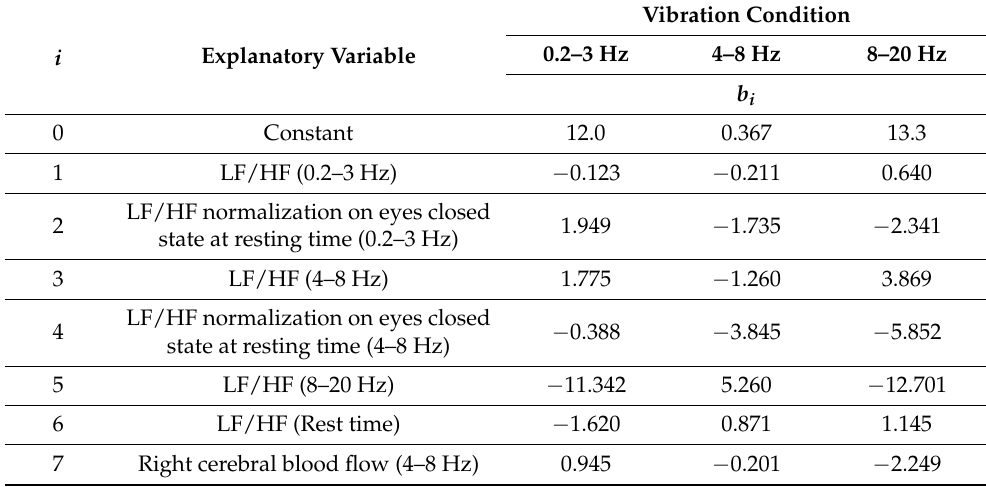
Figure 13. Results of multiple regression analysis. ( a ) 0.2–3 Hz; ( b ) 4–8 Hz; ( c ) 8–20 Hz. Table 3. Explanatory variables and their values.